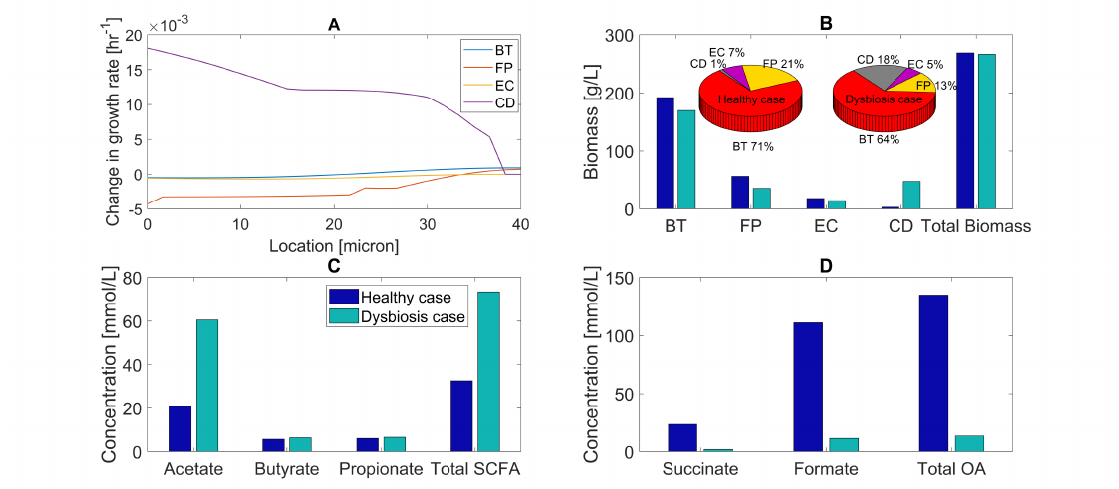
Figure 4. Predicted multispecies biofilm dysbiosis resulting from host-microbiota perturbations in the concentration of the primary bile acid taurocholate. ( A ) Change in species growth rates across the biofilm plotted as the difference between the growth rates for the healthy and dysbiosis case. ( B ) Biomass concentrations (bar graphs) and species abundances (pie charts) averaged across the biofilm for the healthy and dysbiosis case. ( C ) Acetate, butyrate, propionate, and total SCFA concentrations averaged across the biofilm. ( D ) Succinate, formate, and total OA concentrations averaged across the